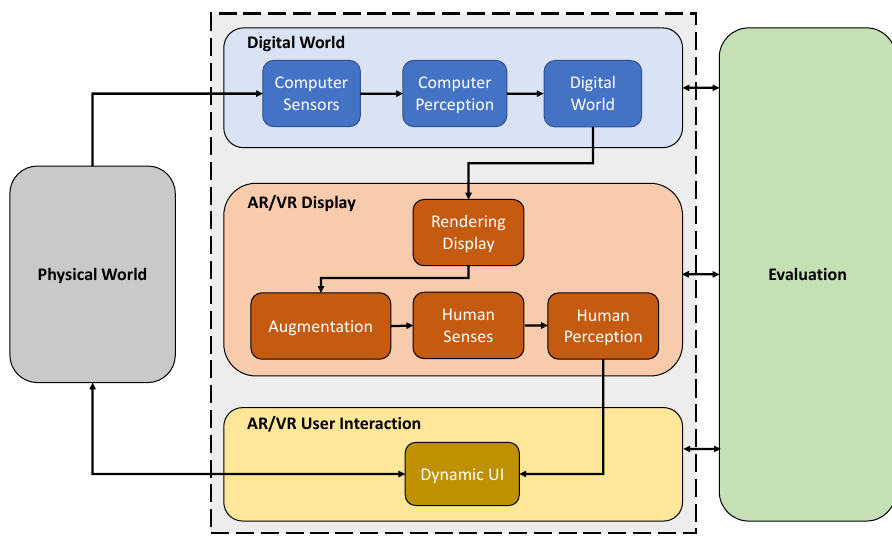
Figure 2. The Medical Augmented Reality Framework consists of four primary components: Dig- ital World, AR/VR Display, AR/VR User Interaction, and evaluation. An MARS perceives the Physical World with its sensors and processes in a medium that users may perceive and interact with through the AR/VR interfaces. Evaluation is integral to the system’s conception, development, and